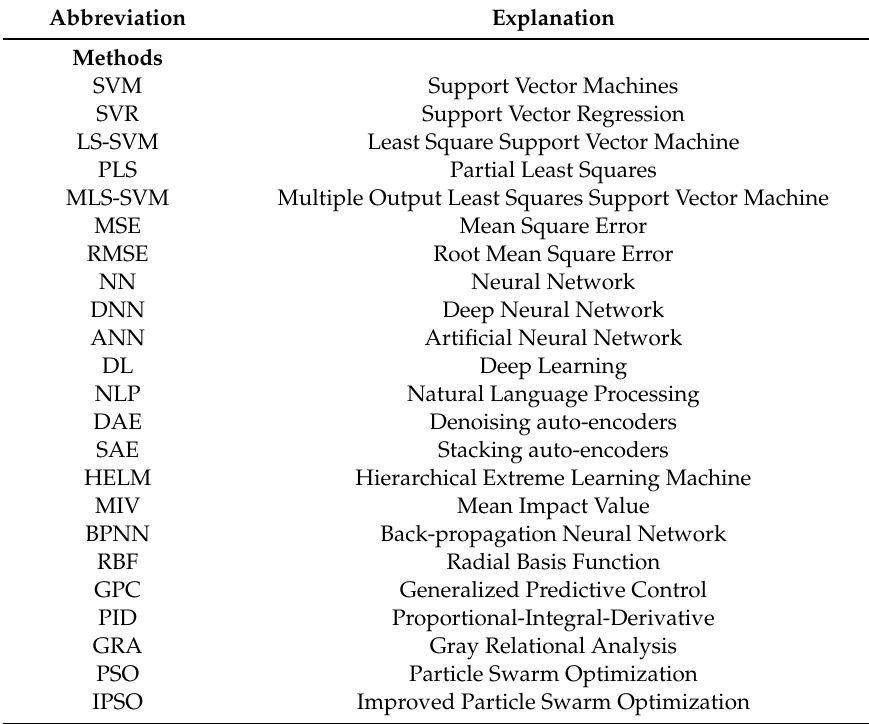
Table A1. List of